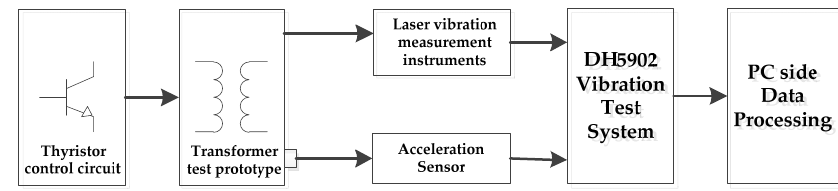
Figure 23. The overall flow chart of the experiment.